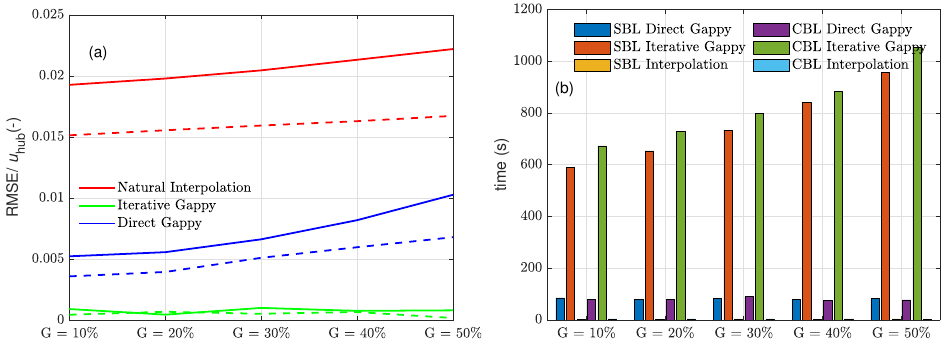
Figure 12. ( a ) Error comparison for the three methods. Solid and dotted lines indicate the CBL and SBL cases, respectively. ( b ) Comparison of the computational time taken for the three methods to reconstruct missing points.